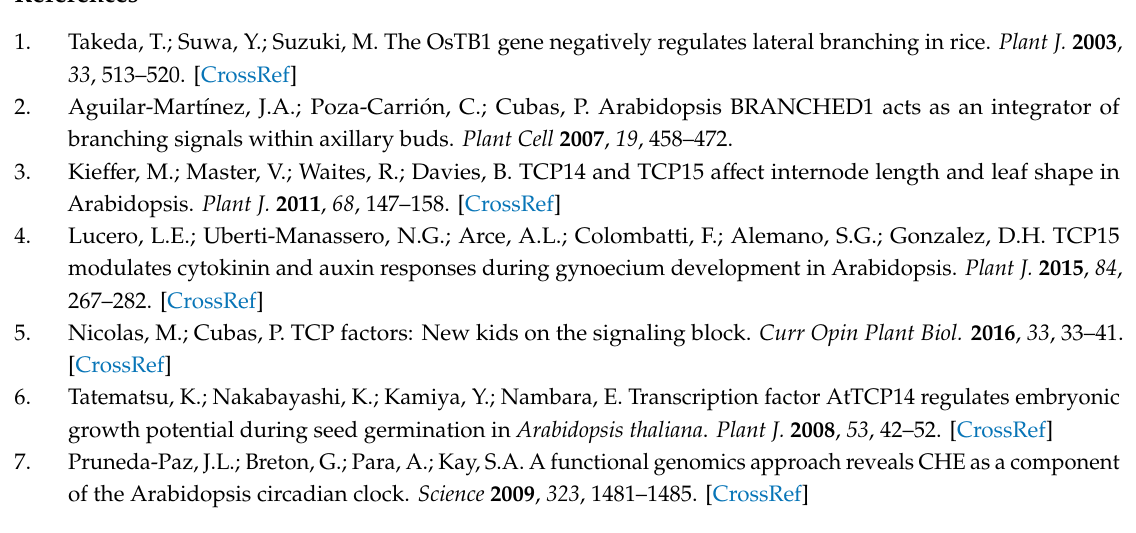
s1. Table S1: Candidate TCP genes identified in land plants in the present study. Table S2: Protein motifs of TCP proteins in the land plants examined in the present study. Table S3: Predicted microRNA-target site of TCP genes in the land plants examined in the present study. Table S4: Nucleotide substitution rate (Ka / Ks) of miR319-target and non-miR319-target genes. Table S5: Details of the TCP protein interaction network in Arabidopsis thaliana . Glycine max , Oryza sativa , Zea mays , and Physcomitrella patens . Table S6: The annotation of proteins in the interaction network of TCP proteins in A. thaliana , G. max , O. sativa , Z. mays , and P. patens . Figure S1: Phylogenetic tree of the 535 TCP proteins used in the present study. Figure S2: Sequence logos of the TCP domains in Class II TCP proteins. Figure S3: Expression profiles of TCP genes in Marchantia. polymorpha , P. patens , G. max , Z. mays , and O. sativa across di ff erent developmental stages and organs. Figure S4: Protein interaction networks of Class I TCP proteins in (A) A. thaliana , (B) G. max , (C) O. sativa , (D) Z. mays , and (E) P. patens according to the STRING dataset. Figure S5. Protein interaction networks of CIN Class II TCP proteins in (A) A. thaliana , (B) G. max , (C) O. sativa , (D) Z. mays , and (E) P. patens according to the STRING